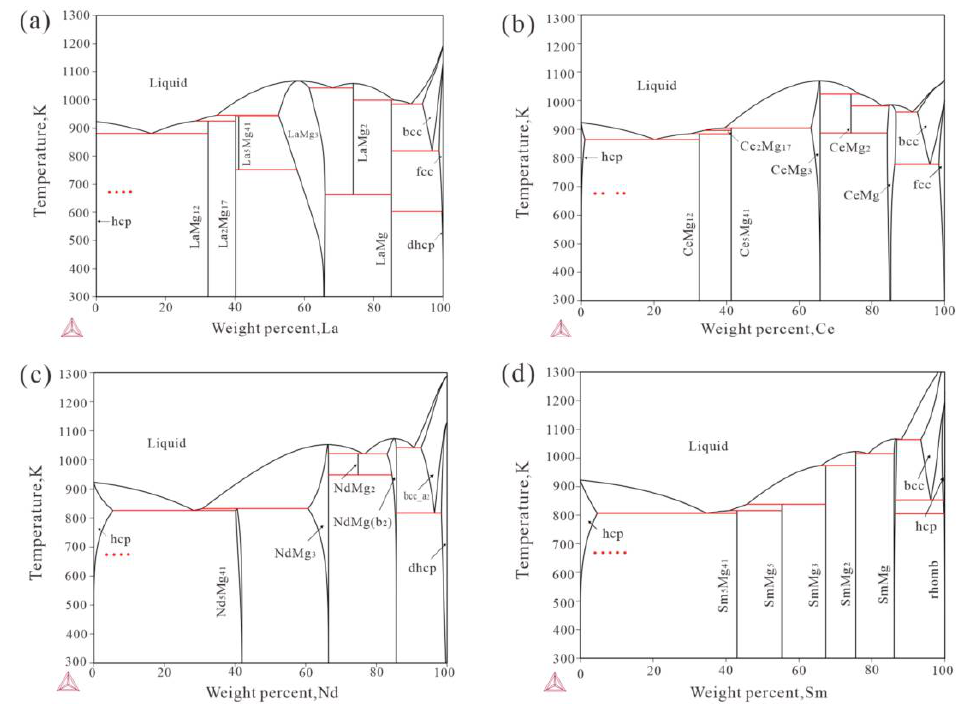
Figure 1. Phase diagram of: ( a ) the Mg-La system; ( b ) the Mg-Ce system; ( c ) the Mg-Nd system; ( d ) the Mg-Sm system.